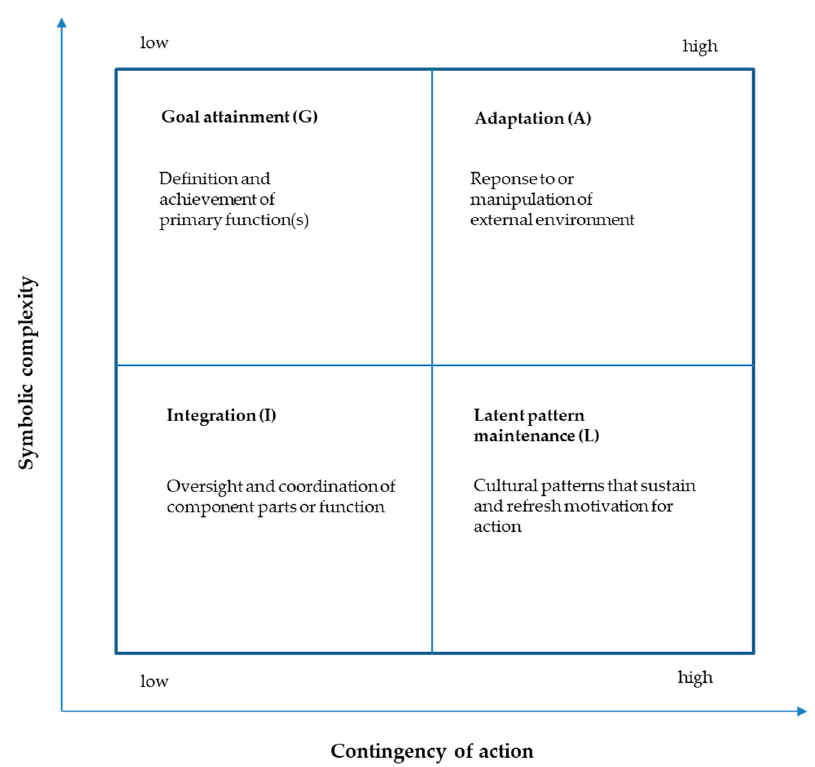
Figure 2. Our adaption of the Elam, A., and Sardana, D. (2008), AGIL scheme from T. Parsons’ model with four quadrants corresponding to the four dimensions of the scheme.